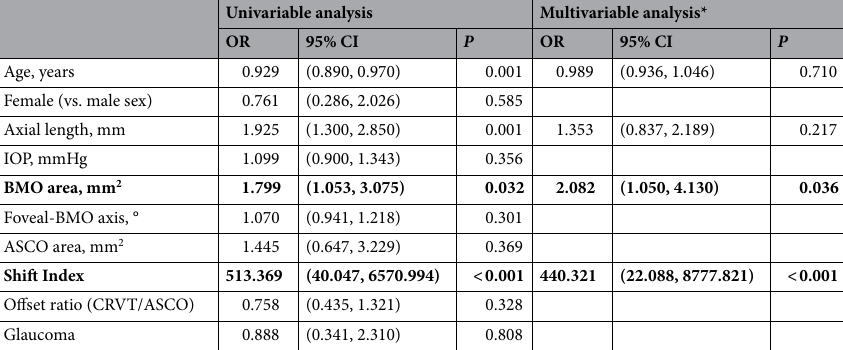
Table 4. Risk factors for incomplete demarcation of anterior scleral opening (ASCO) margin. Statistically significant values ( P < 0.05) are shown in bold. OR, Odds ratio; CI, Confidence interval; IOP, Intraocular pressure; BMO, Bruch’s membrane opening; ASCO, Anterior scleral canal opening. *Variables with P < 0.10 in the univariable analysis were included in the subsequent multivariable analysis.